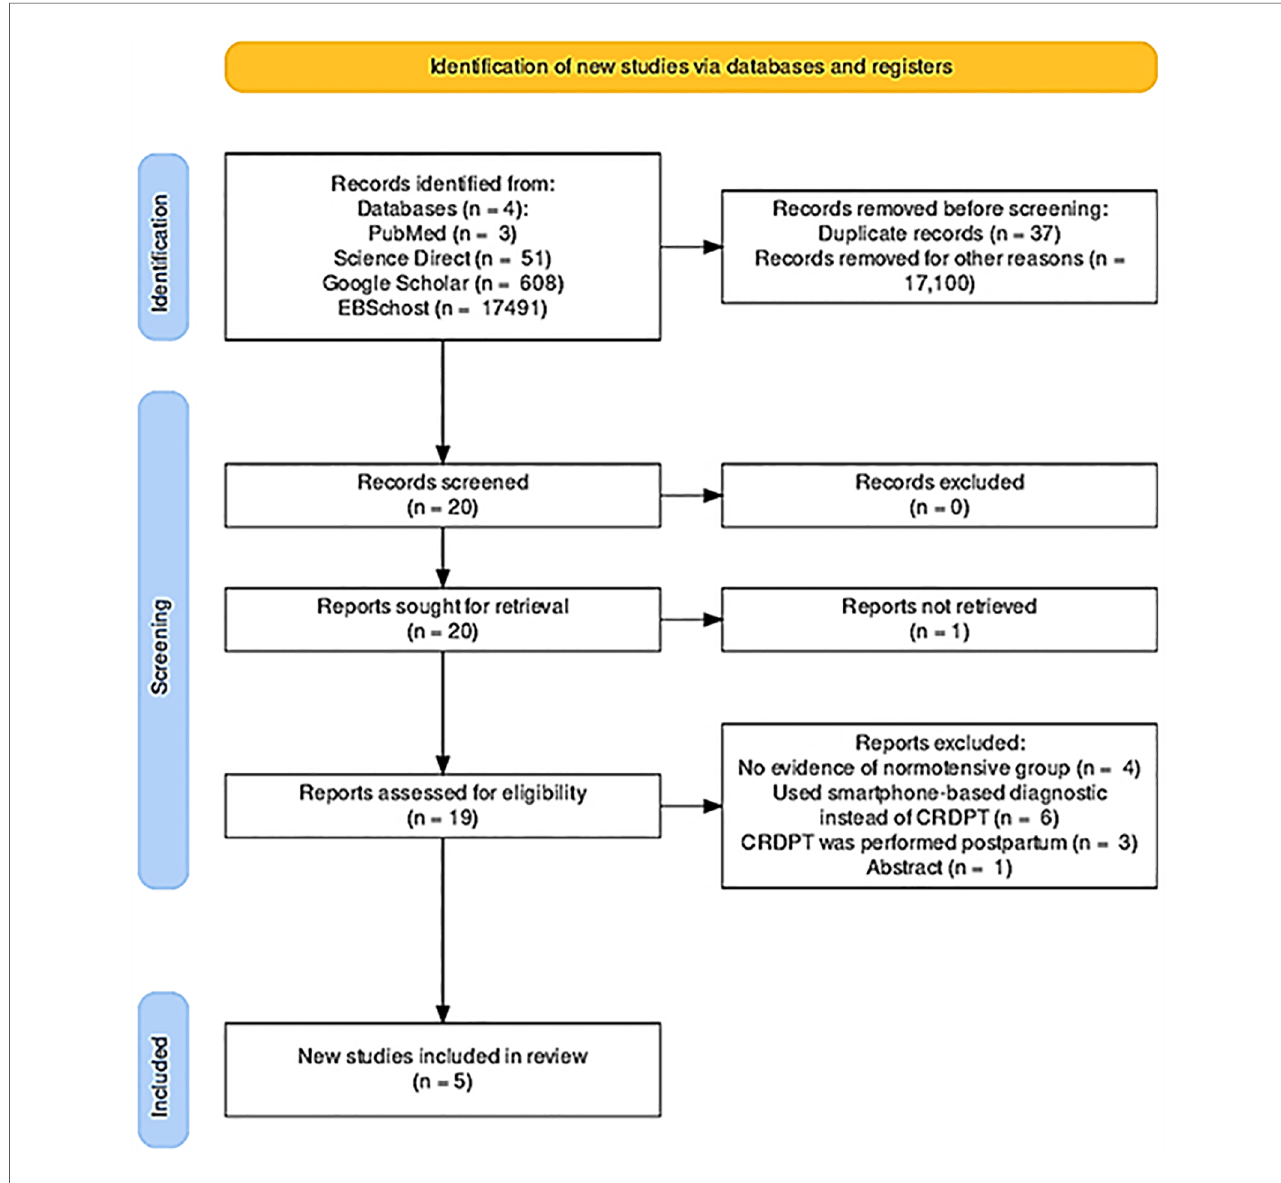
FIGURE 1 PRISMA fl ow diagram of the study selection